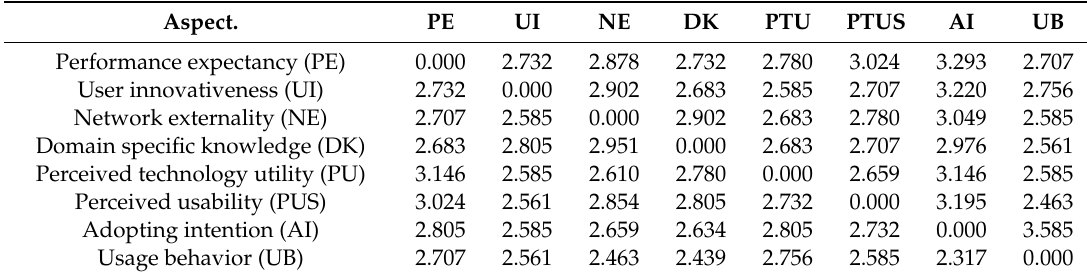
Table A3. The direct-influence matrix A .